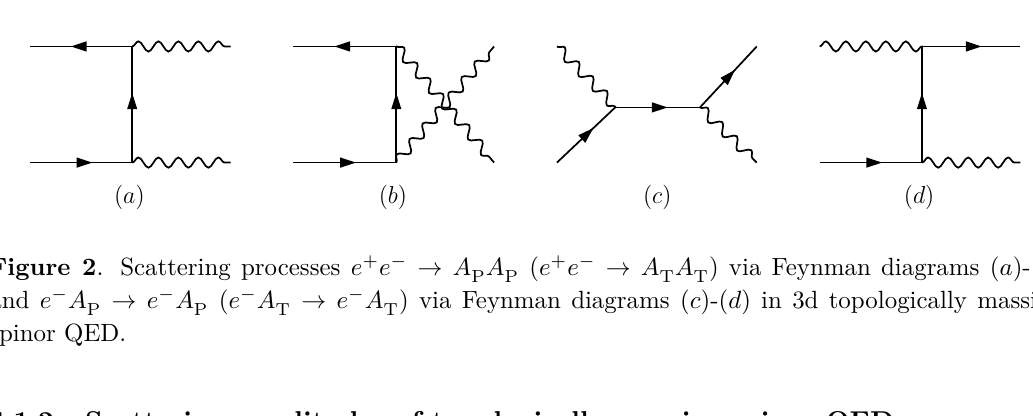
Figure 2 . Scattering processes e + e − → A A ( e + e − → A P P and e − A → e − A ( e − A → e − A ) via Feynman diagrams ( c ) - ( d ) in 3d topologically massive P P T T spinor